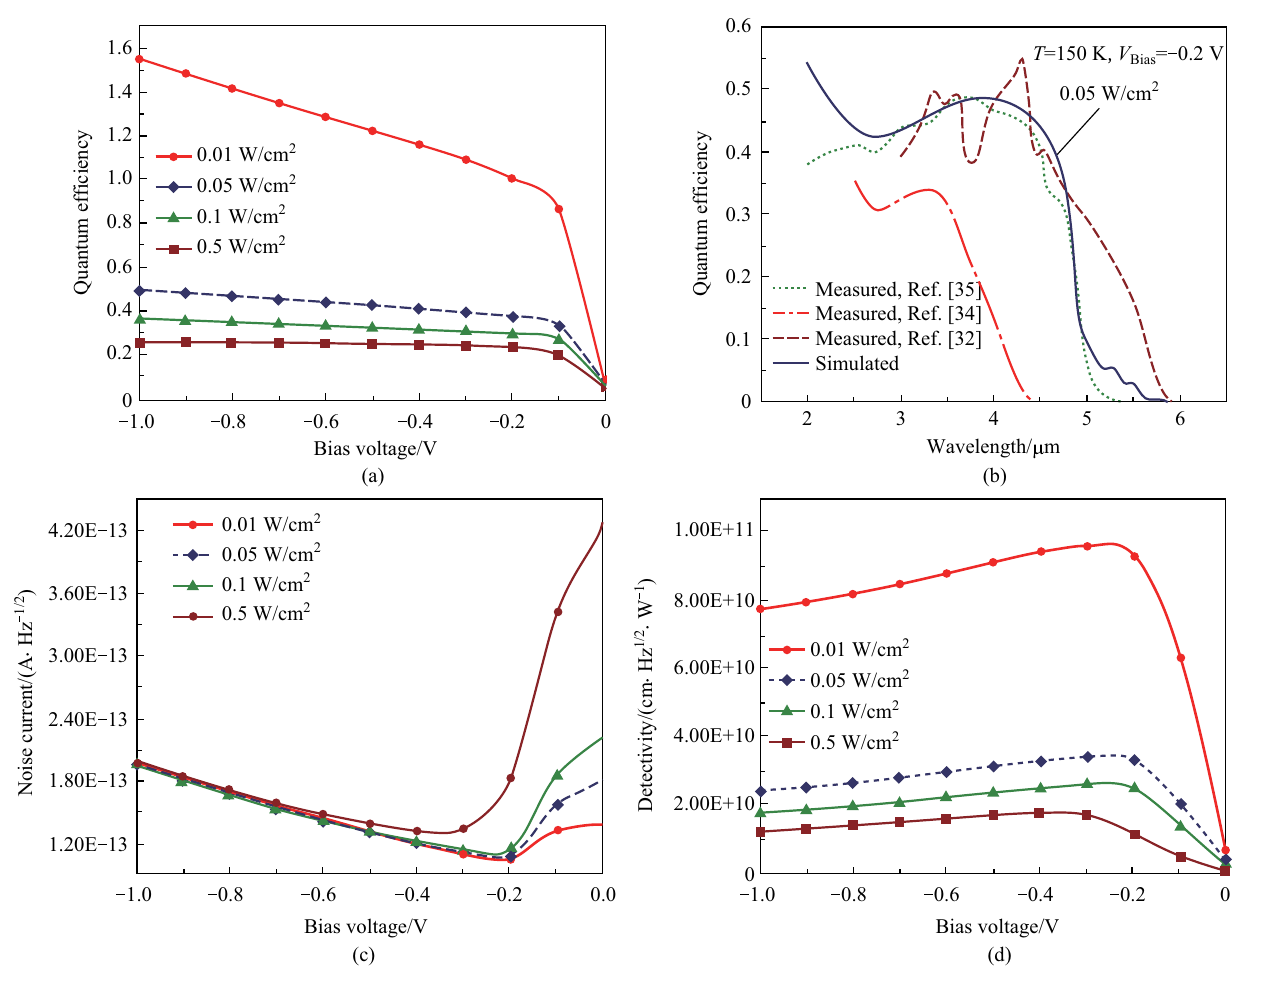
Fig. 6 Performance of the δ-DCGB nBn-PD device at 150K. a QE versus applied bias voltages with different intensities of infrared radiations. b QE versus wavelength compared to the measured values. c Noise current. d Specific detectivity versus applied bias voltages with different intensities of infrared radiations